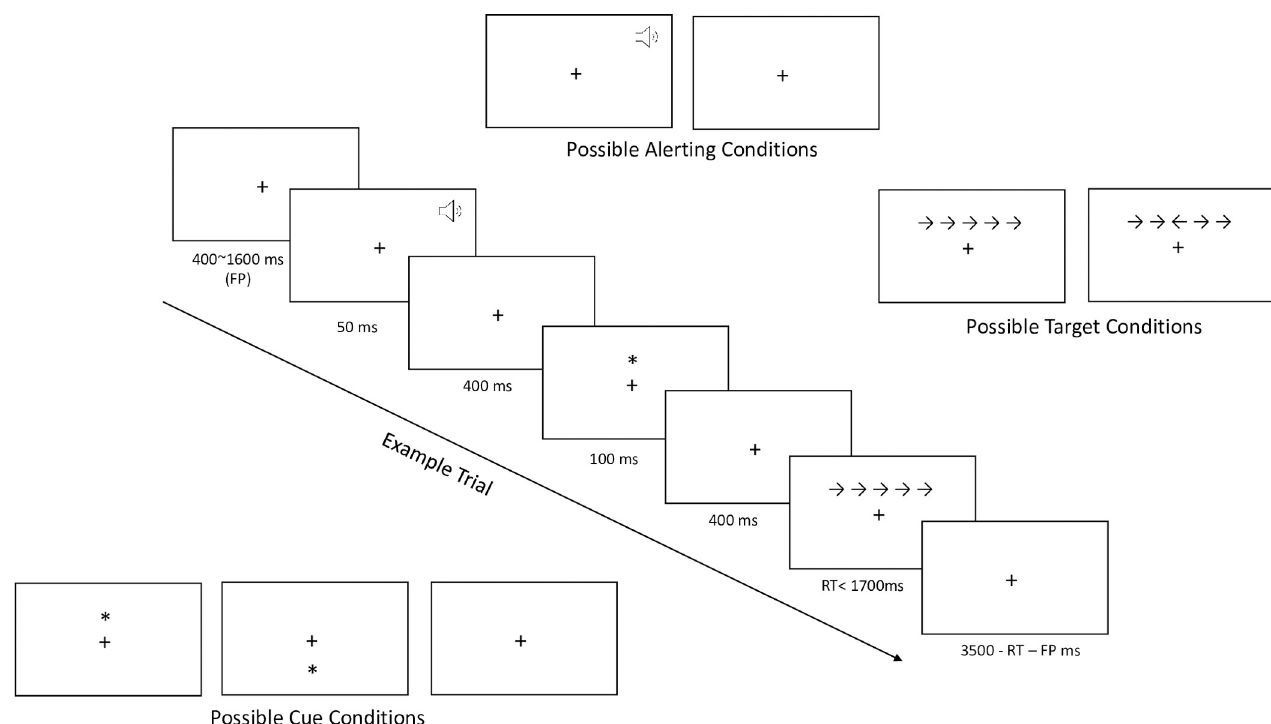
Fig 1. Attention Network Test (ANT-I). Example trial: Following a 400–1600 millisecond (ms) inter-trial period, the target stimulus is preceded by an alerting tone (second top panel) and a valid orienting cue (fourth top panel). The target (center) arrow is surrounded by incongruent flankers (second bottom panel). Possible cue, target (i.e., congruent and incongruent flankers), and alerting conditions are also